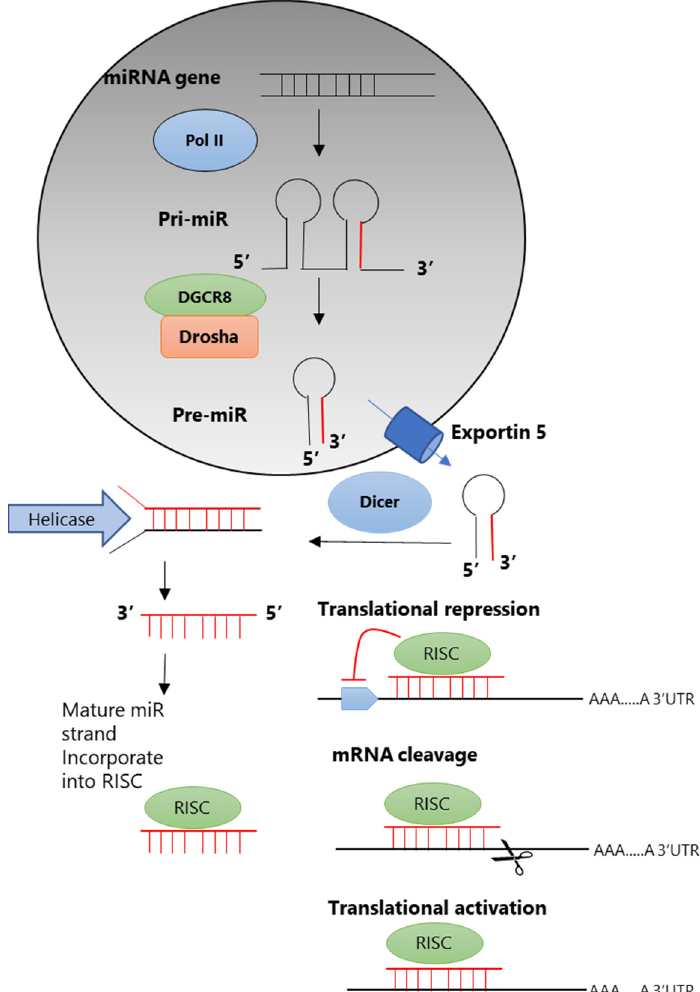
Figure 1. Biogenesis and mechanisms of action of MicroRNAs (miRNAs) [7]. RNA-induced silencing complex, RISC.